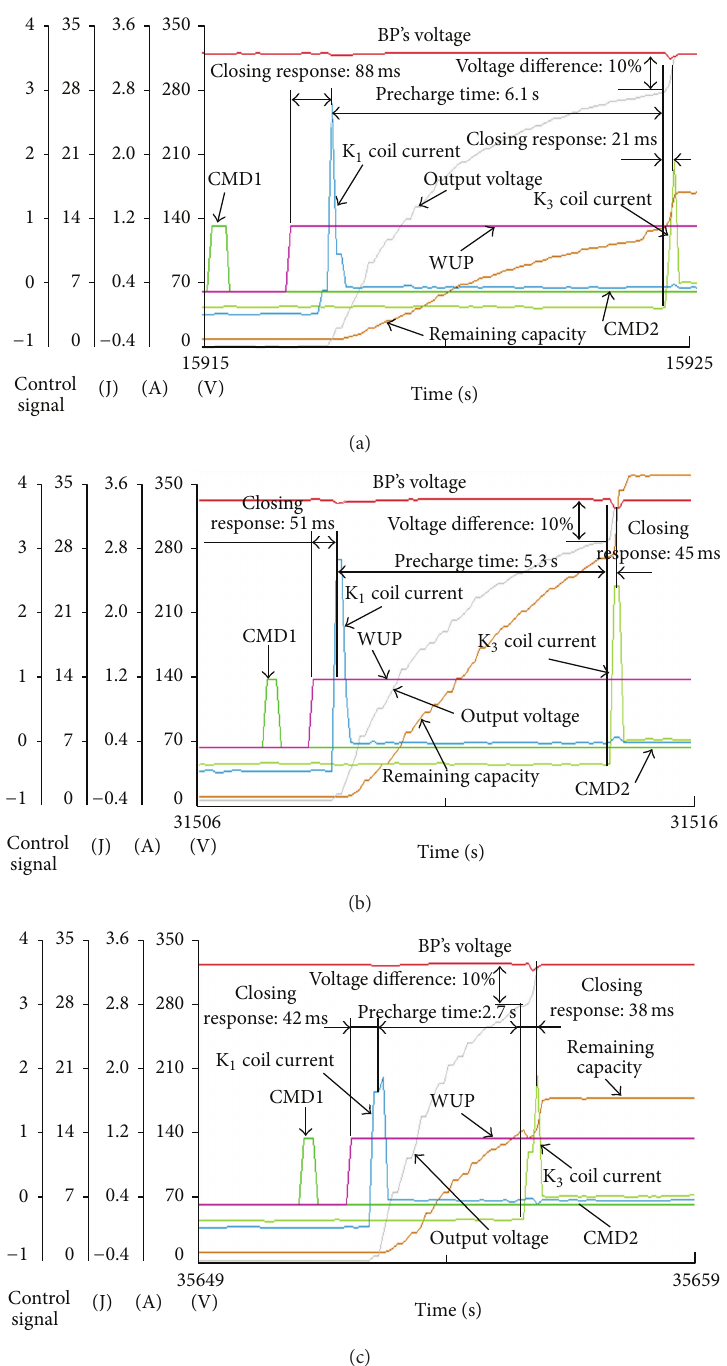
Figure 17: The contrastive experiment of different precharge resistance and load